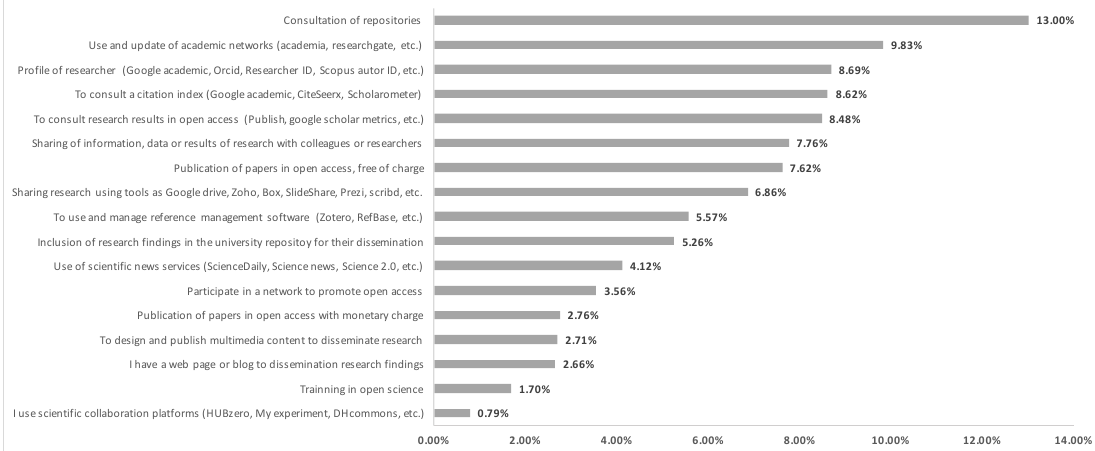
Figure A4. Open science tools used by Colombian researchers, according to the survey results.